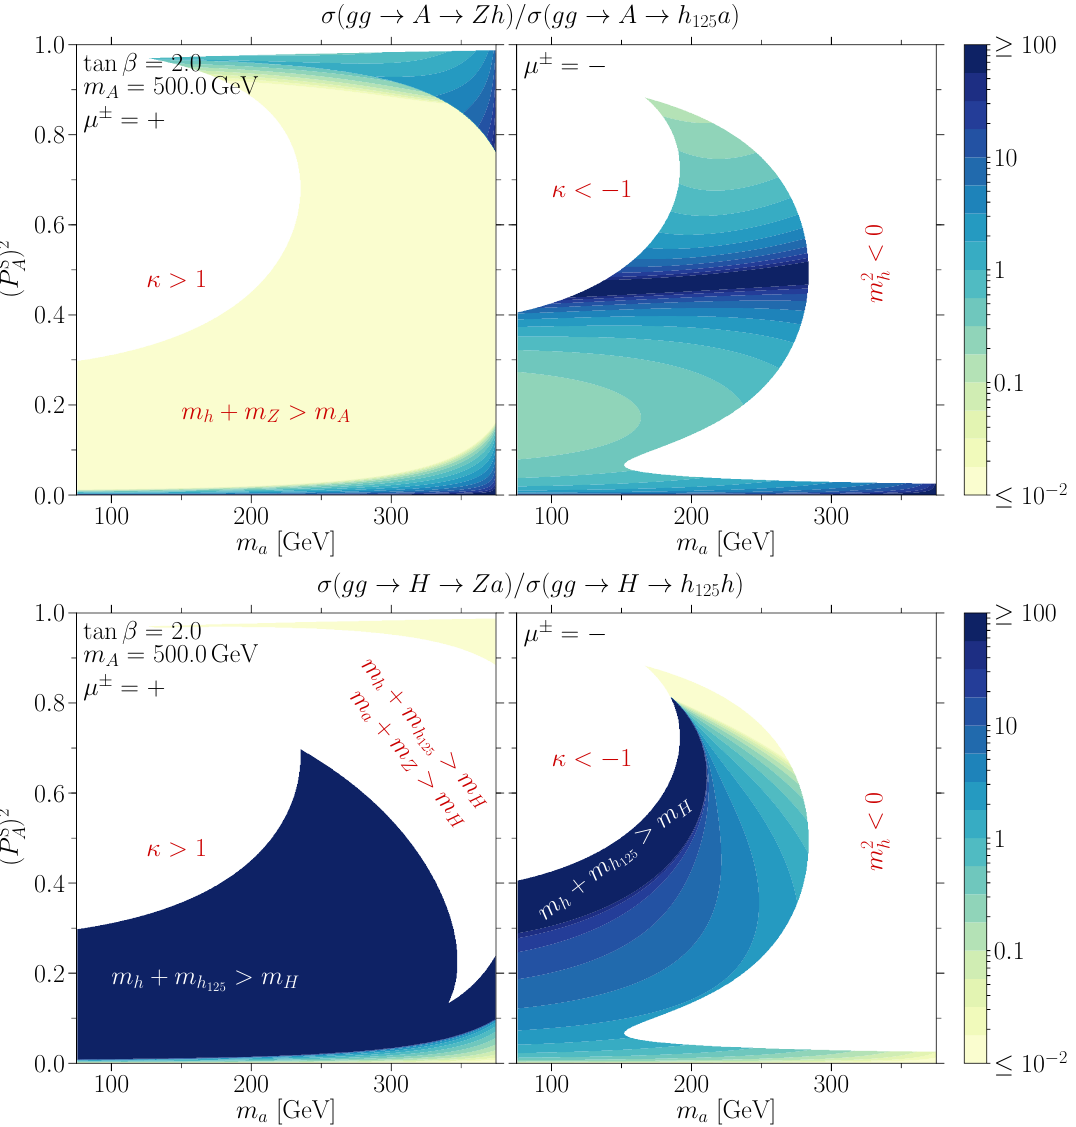
Figure 4 . Ratios of various heavy Higgs cross sections given in eq. (3.1) [(3.2)] for the top [bottom] panel in the m a {( P S ) 2 plane. Recall that m a is the mass of the lighter CP-odd mass eigenstate and A P S parameterizes the mixing angle in the CP-odd sector. Speci(cid:12)cally, ( P S ) 2 is the singlet fraction A A of the heavier CP-odd state A and numerically ( P S ) 2 = ( P NSM ) 2 , where ( P NSM ) 2 is the (non SM- a a A like) doublet component of the lighter CP-odd state a , cf. eq. (2.26). The remaining parameters are (cid:12)xed to m A = 500 GeV and tan (cid:12) = 2, and the left and right panels are for the two di(cid:11)erent (cid:22) (cid:6) solutions, cf. eq. (2.36). The red/white labels indicate regions of parameter space where one or more of the channels are kinematically forbidden, the lighter non SM-like CP-even state m h becomes tachyonic, or (cid:20) takes large values j (cid:20) j > 1.